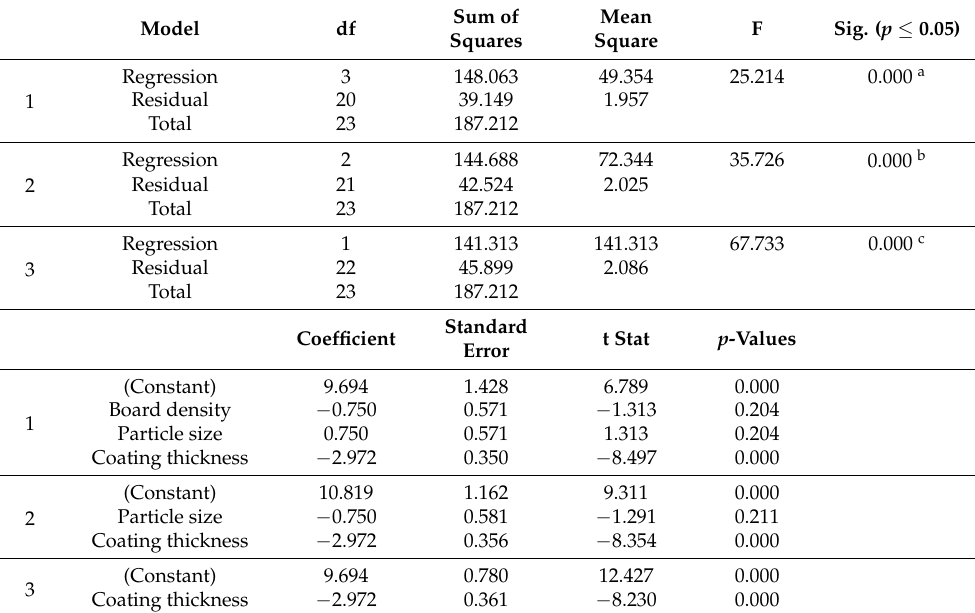
Figure 5. Surface roughness (Ra) values of bamboo particle board at various PU coating thickness with difference particle size and board density. Table 2. Analysis of variance (ANOVA) of multiple regression for the effect of PU coating thickness, different particle size, and board density on the surface roughness (Ra) values.